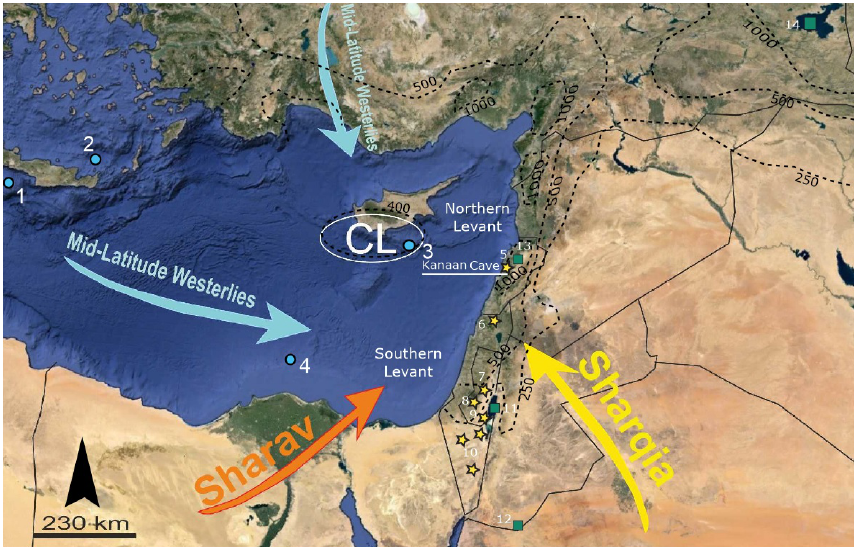
Figure 1. The eastern Mediterranean showing the location of palaeoclimate records including this study and the major wind trajectories (Saaroni et al., 1998), including the mid-latitude westerlies, and occasional incursions from the Sharav cyclone and the Sharqiya. The north– south and east–west precipitation gradients are indicated by dashed dark lines (isohyets in mm). CL: Cyprus Low. The locations of Kanaan Cave and other Levantine palaeoclimatic records spanning the MIS 5 period cited in the text are numbered 1 to 14. Records derived from marine studies are indicated by points, lake level reconstructions and pollen data by rectangles, and speleothems by stars. (1) Core MD 70-41 (Emeis et al., 2003); (2) core LC21 (Grant et al., 2012); (3) core ODP Site 967 (Rohling et al., 2002, 2004; Emeis et al., 2003; Scrivner et al., 2004); (4) core ODP Site 968 (Ziegler et al., 2010); (5) Kanaan Cave; (6) Peqiin Cave (Bar-Matthews et al., 2003); (7) West Jerusalem Cave (Frumkin et al., 1999, 2000); (8) Soreq Cave (Bar-Matthews et al., 2000, 2003); (9) Tsavoa Cave (Vaks et al., 2006, 2013); (10) Negev composite speleothems from Ashalim, Hol-Zakh, and Ma’ale-ha-Meyshar caves (Vaks et al., 2010); (11) lakes of the Dead Sea basin (Kolodny et al., 2005; Waldmann et al., 2009; Lisker et al., 2010); (12) lake formation at Mudawwara (Petit-Maire et al., 2010); (13) Yammouneh palaeolake (Develle et al., 2011; Gasse et al., 2011, 2015); and (14) Lake Van (Shtokhete et al., 2014; Litt et al.,